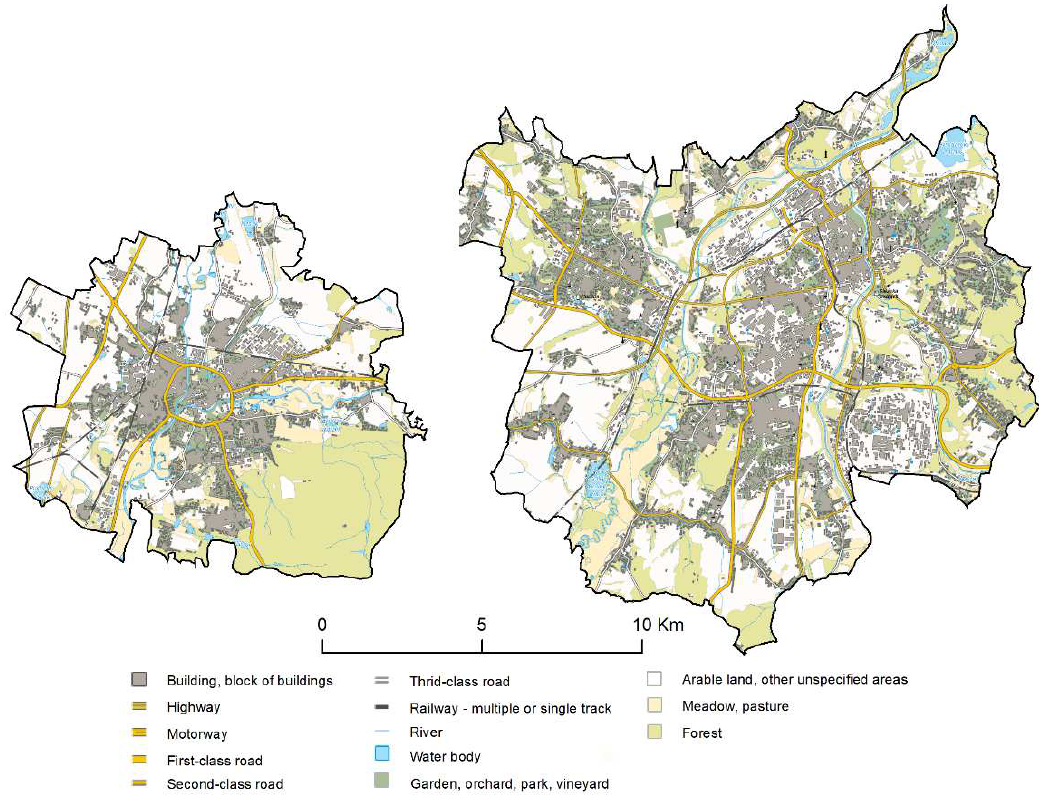
ISPRS Int. J. Geo-Inf. 2022 , 11 , x FOR PEER REVIEW Figure 5. Land use in Hradec Kralove and Ostrava (Data50, COSMC 2021). Figure 5. Land use in Hradec Kralove and Ostrava (Data50, COSMC 2021).